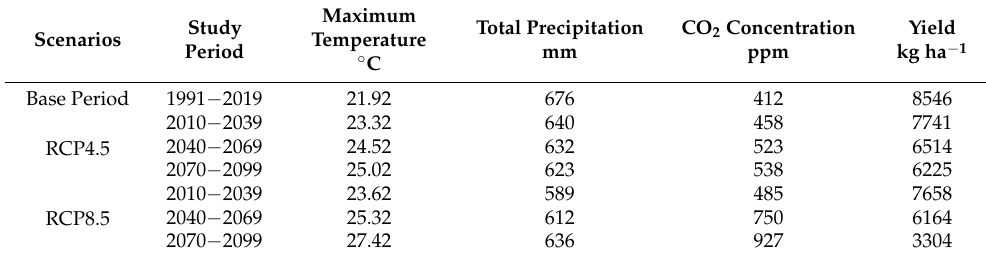
Table 4. Summarized average climatic parameters along with average yield under different climate change scenarios during the maize growing season (May–September).